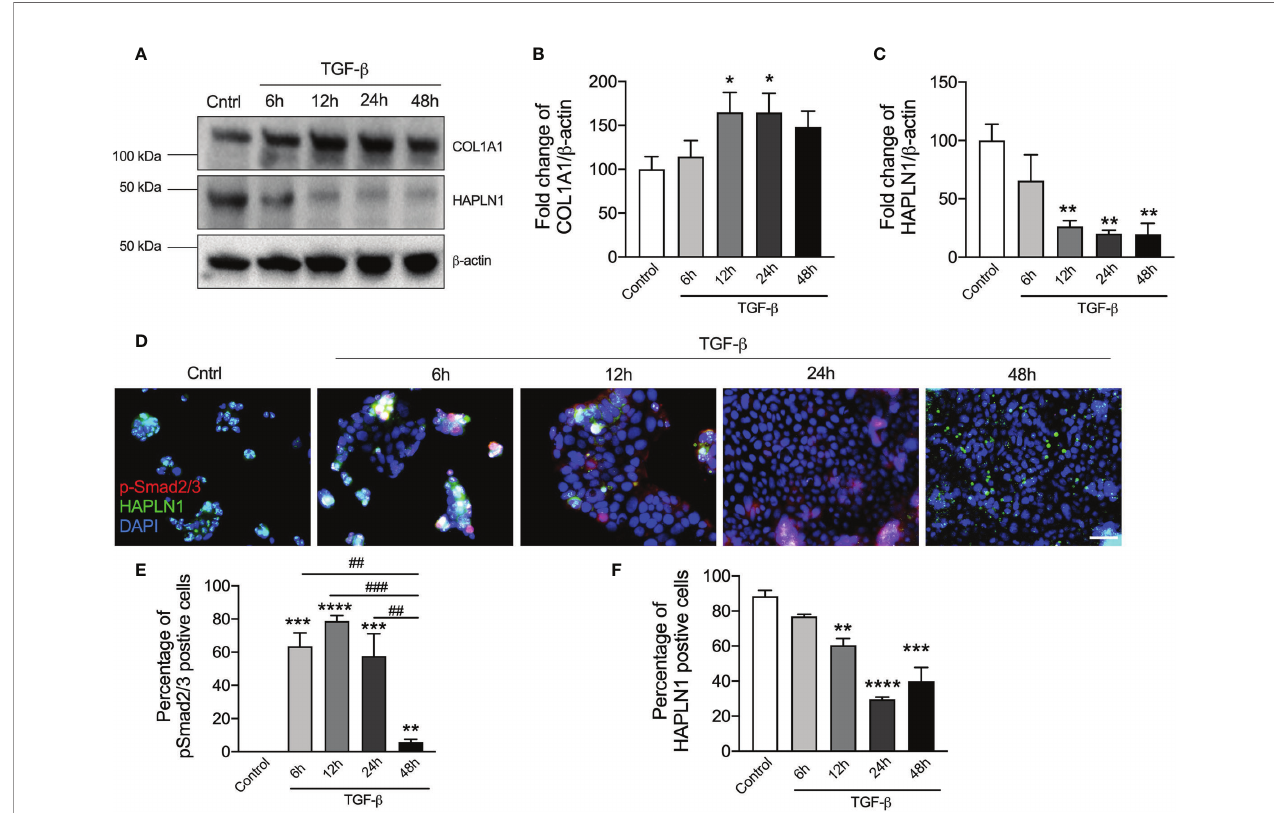
FIGURE 3 | TGF- b stimulation reduces HAPLN1 protein in human colorectal cancer (CRC) cells. Human CRC epithelial cells (Caco-2) were challenged with recombinant TGF- b protein (5 ng/ m l), and controls cells received media. (A) HAPLN1 and COL1A1 protein levels were assessed in cell lysates over a time course (6, 12, 24, and 48 h) of TGF- b challenge by immunoblot. Fold change of densitometry of HAPLN1 (B) and COL1A1 (C) was normalized to b -actin. (D) Caco-2 cells were stained with HAPLN1 and nuclei were stained with DAPI and assessed using immuno fl uorescence ( n = 4, scale bar = 100 m m). p-Smad2/3 (E) and HAPLN1 (F) -positive cells were normalized to total cells to determine the percentage of HAPLN1-positive cells. Results are mean ± SEM. * P < 0.05, ** P < 0.01, *** P < 0.001, **** P < 0.0001 compared with control cells that received media. ## P < 0.01, ### P < 0.001 compared with TGF- b -challenged cells after 48